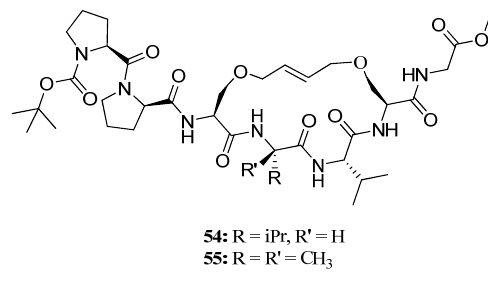
Figure 14. Cyclic analogues 54 and 55 of the Pro138-Gly144 segment of human AQP4 helical conformation by an RCM-derived bridge linking the side chains stabilized in a 3 10 of residues 3 and